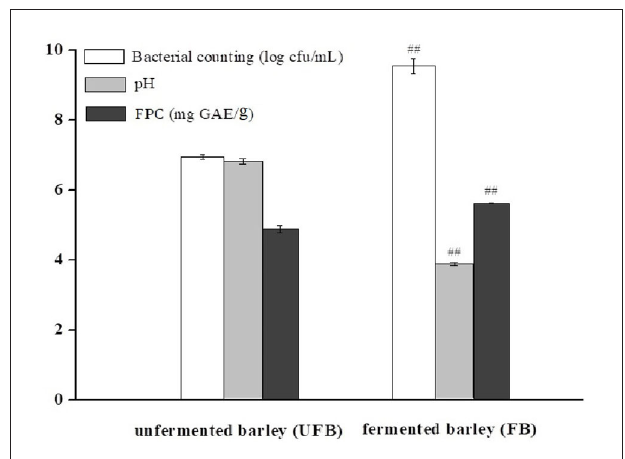
FIGURE 1 | Bacterial counting, pH, and free phenolic content (FPC) of unfermented barley (UFB) and fermented barley (FB). Bars represented mean values ± SD ( n = 5.00). For the same index, ## indicated significant difference at the level of P < 0.01 between UFB and FB.